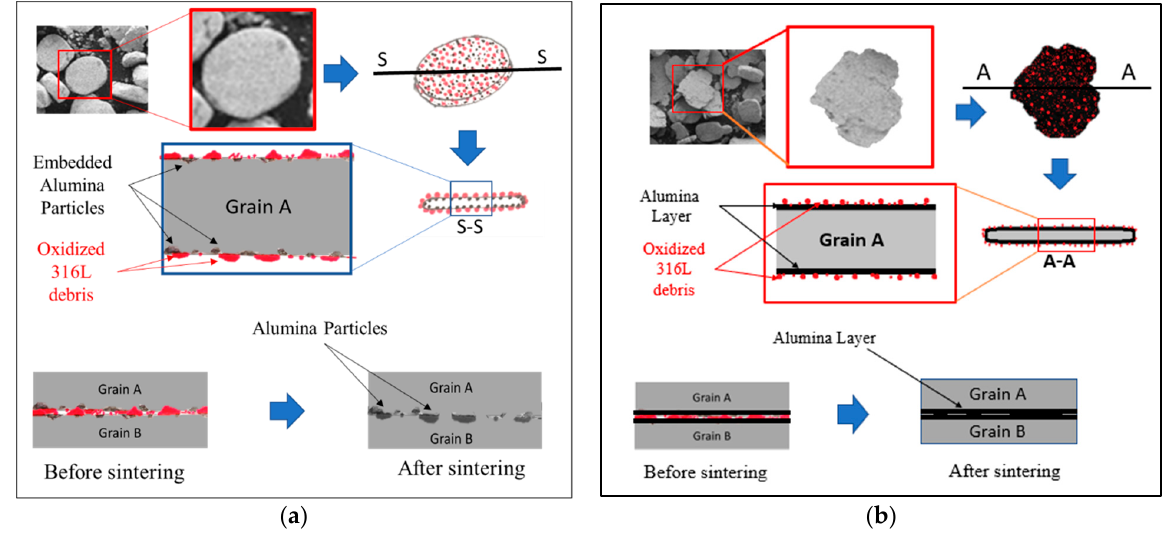
Figure 10. Schematic representation of the sintering behaviour at the grain boundaries of the 0.33 wt% and 1 wt% alumina composites. ( a ) 0.33 wt% alumina; ( b ) 1 wt% alumina.